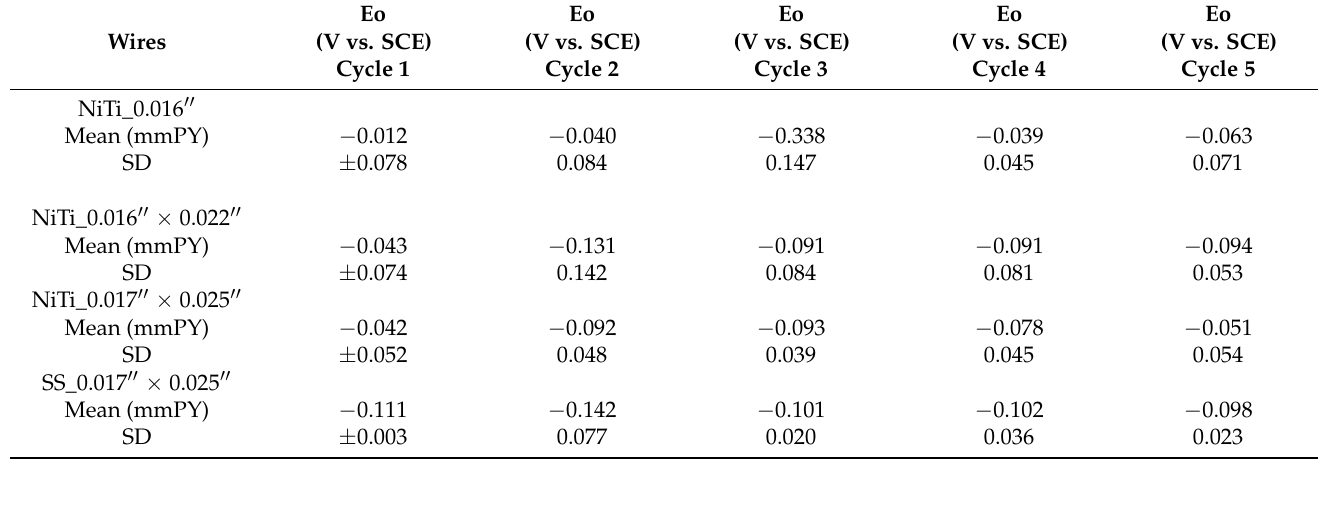
Table 5. The results for the mean corrosion potential in each of the five cycles.